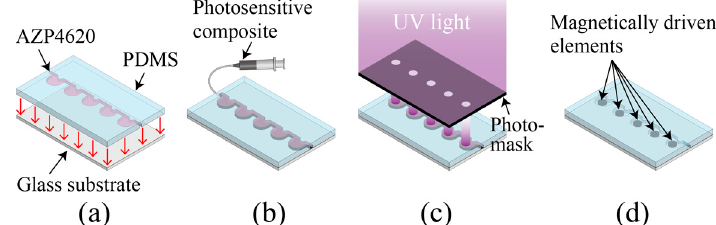
Figure 3. Schematic diagrams of proposed fabrication process: ( a ) Making closed channel; ( b ) introducing composite into channel; ( c ) patterning of composite; and ( d ) forming and releasing microvalves.